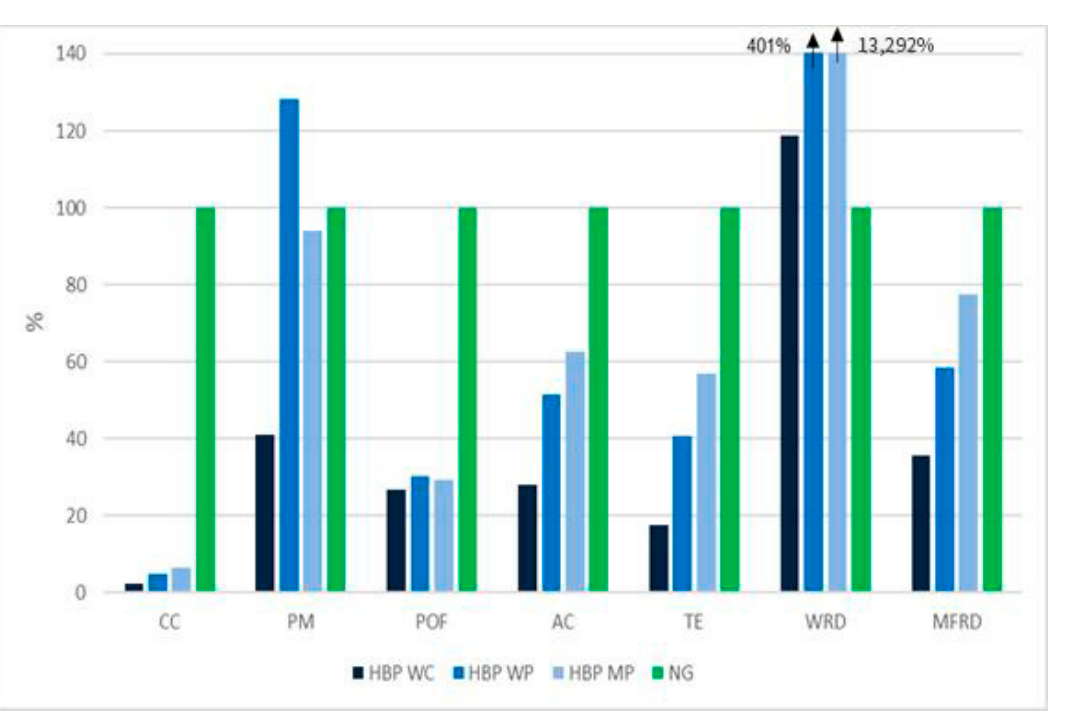
Figure 7. Comparison of HBP technology with competing technologies (for 1 MJ heat). Values are normalized taking as 100% the impacts of the natural gas boiler. CC = Climate change, PM = Particulate matter, POF = Photochemical ozone formation, AC = Acidification, TE = Terrestrial